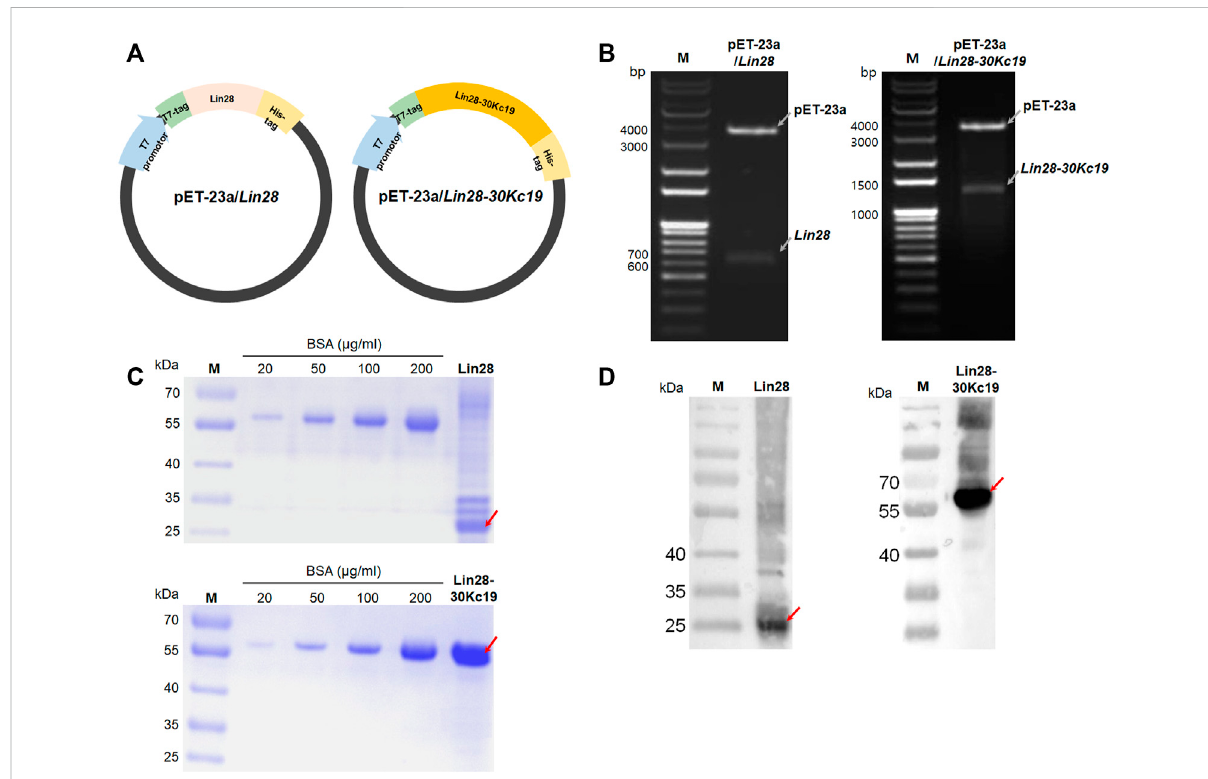
Gene construction and protein expression of Lin28 and Lin28-30Kc19. (A) Construction of E. coli expression vectors pET-23a/ Lin28 and pET-23a/ Lin28-30Kc19 . (B) PCR gel for con fi rming gene cloning of both genes, Lin28 and Lin28-30Kc19 in the expression vector pET-23a. Gray arrows indicate each gene of pET-23a , Lin28, and Lin28-30Kc19 , respectively. (C) SDS-PAGE gel for the quanti fi cation of puri fi ed proteins, Lin28 and Lin28-30Kc19. (D) Western blot analysis of the recombinant proteins. Red arrows indicate the Lin28 protein and the Lin28-30Kc19 protein, respectively. M indicates the protein marker